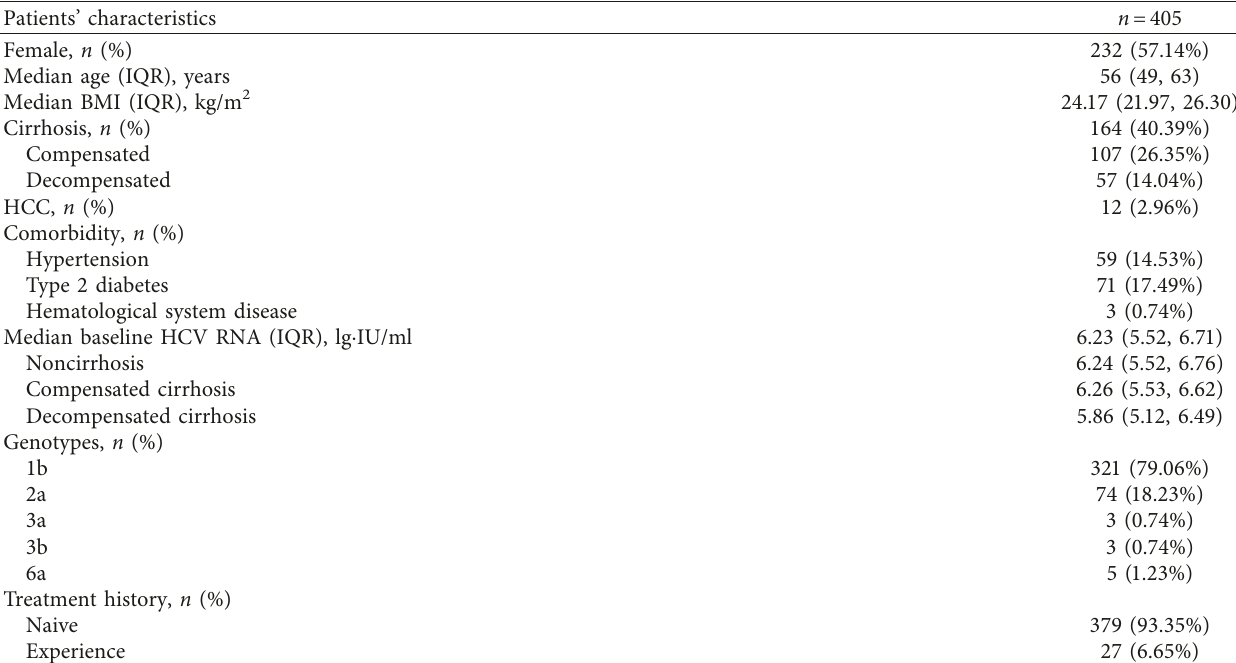
Table 4: Clinical and virological characteristics of chronic hepatitis C patients with DAAs treatment.